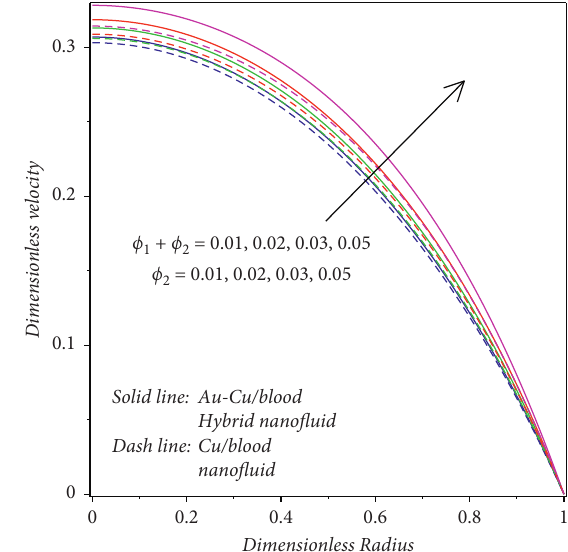
Figure 6: Behaviour of ϕ